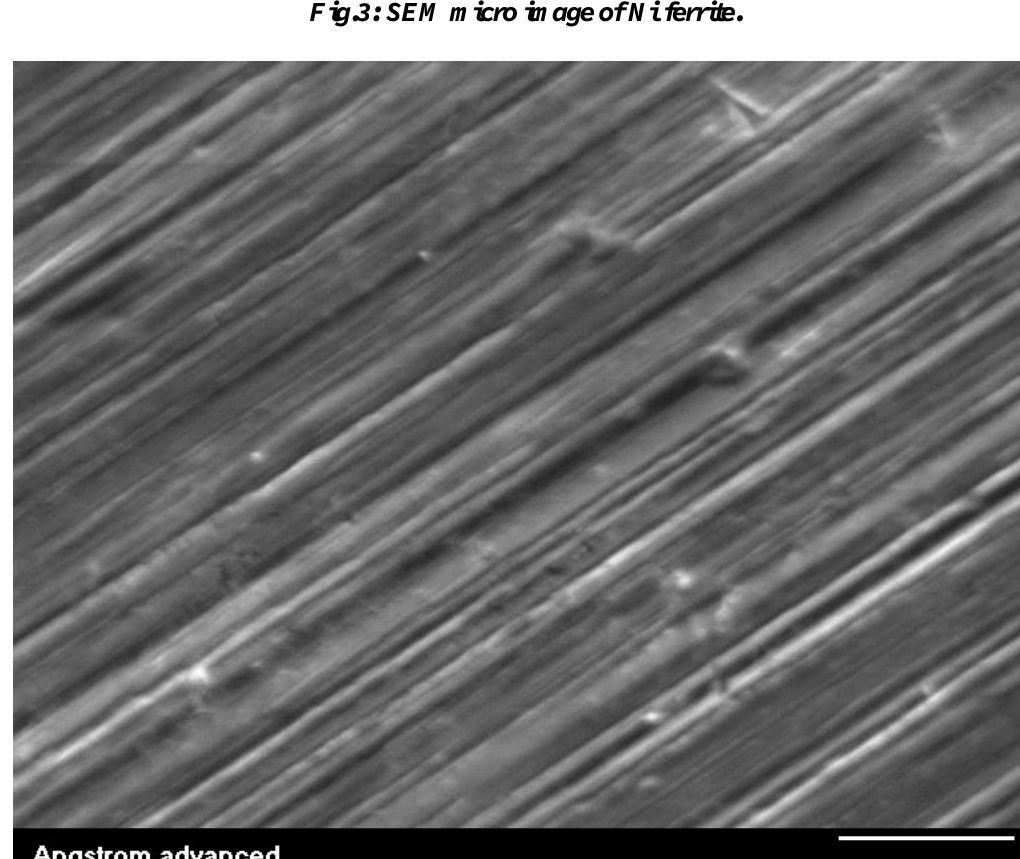
Fig.3: SEM micro image of Ni ferrite.